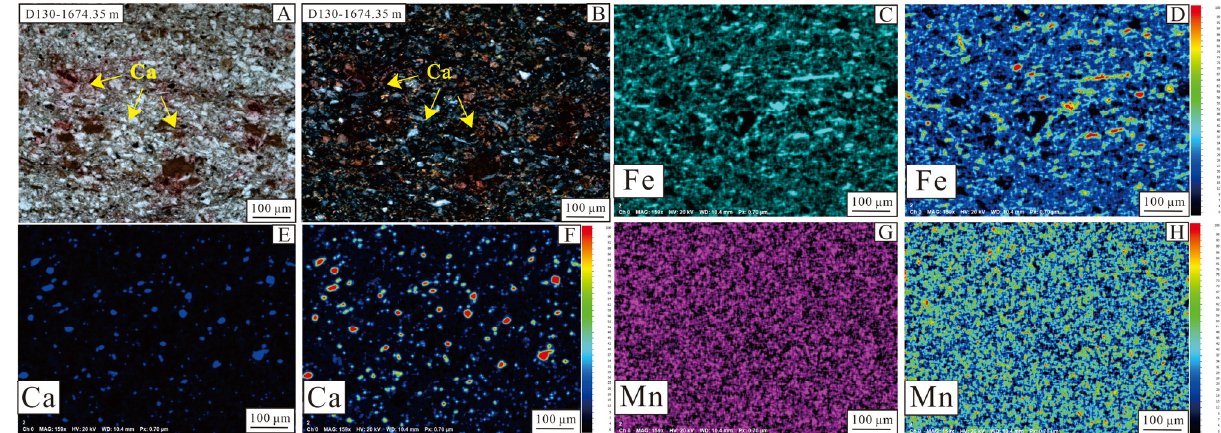
Figure 14. X-ray fluorescence distribution characteristics of typical types of elements in calcite cement. ( A , B ) Photomicrographs of thin sections under plane-polarized light ( A ) and cross-polarized light ( B ) suggesting the presence of calcite cements in mudstone sample from D130 (1674.35 m). ( C – H ) The distribution of typical elements of Fe, Ca, and Mn, respectively.